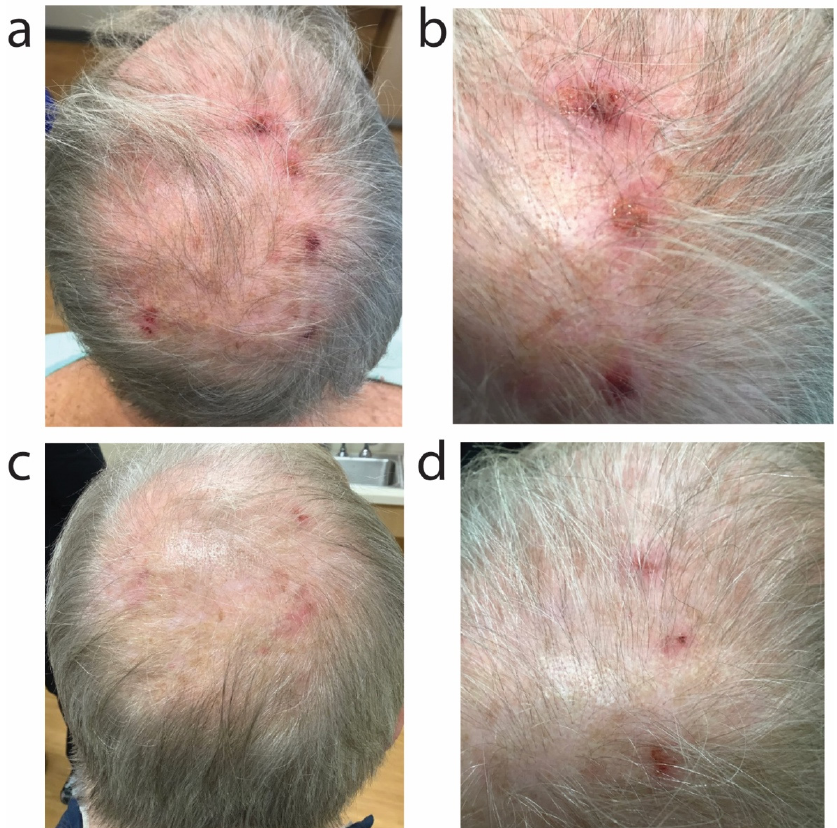
Figure 3 . Scalp folliculitis due to methicillin-sensitive S. aureus improved with oral sarecycline. Global ( a ) and zoomed-in ( b ) clinical photos of the head prior to initiation of sarecycline. Global ( c ) and zoomed-in ( d ) photos demonstrating clinical improvement of the scalp 11 days later, after the patient completed 9 days of oral sarecycline.